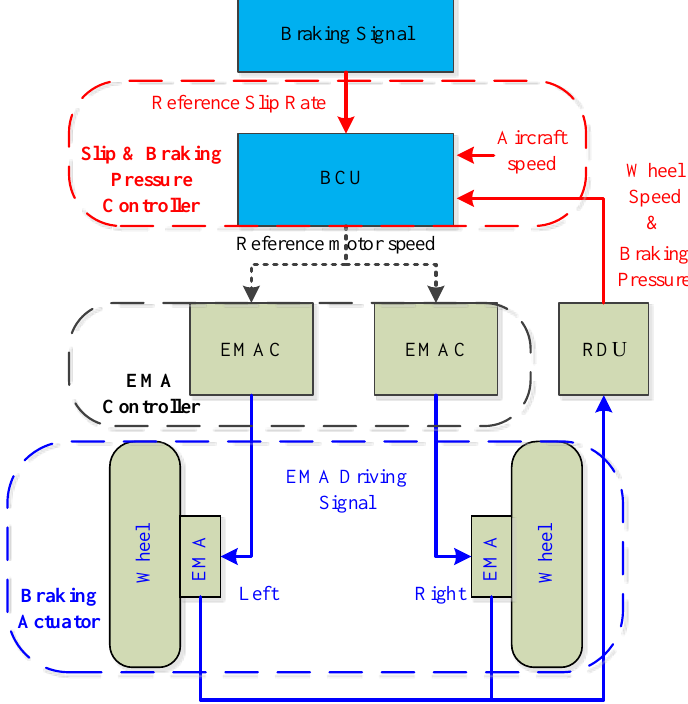
Figure 1. The all-electric aircraft anti-skid braking system structure. In Figure 1, the short dashed arrows represent network communication, and the rounded rectangles in red, black, and blue represent the ABS subsystem, EMA